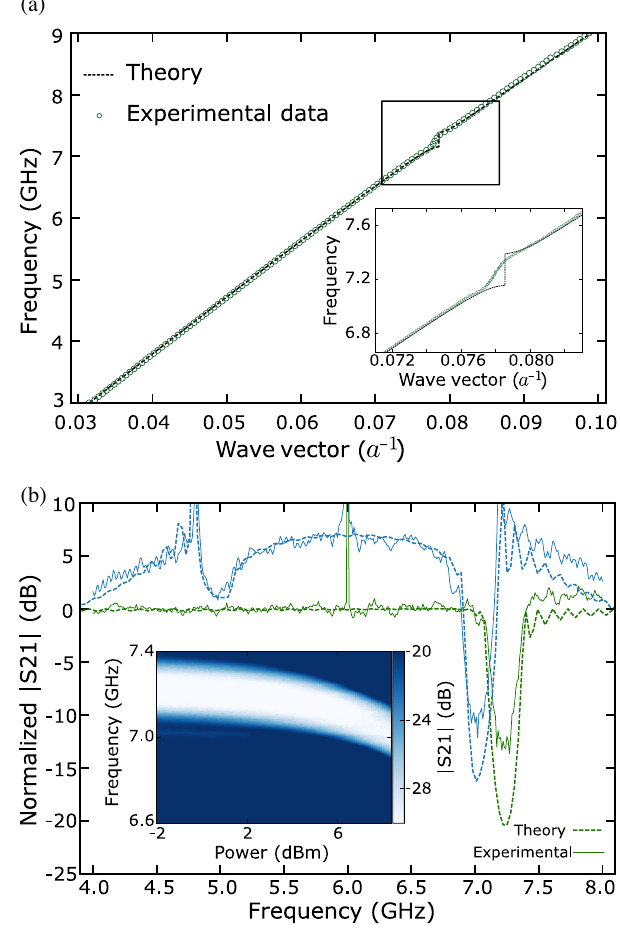
FIG. 2. (a) Dispersion relation of sample A measured at a very low magnetic flux ( Φ = Φ 0 ¼ 0 . 1 ). The theoretical curve is a ¯ L fit to the linear dispersion relation with as a fit parameter. The kink at 7 GHz is the photonic gap created by spatial modulation. Inset: Close-up of the photonic gap. Theory agrees with experimental data and reproduces the gap position with a 0.6% error. (b) Normalized probe transmission of sample A for a ¼ − 135 dBm and for different pump signal power set to P s ¼ − 83 . 8 dBm, blue: = 2 π ¼ 6 GHz, green: P powers ( ω P P ¼ − 70 . 3 dBm). The gap is shifted by more than its width P P at large pump power. Inset: Color map of the probe transmission versus probe frequency and pump